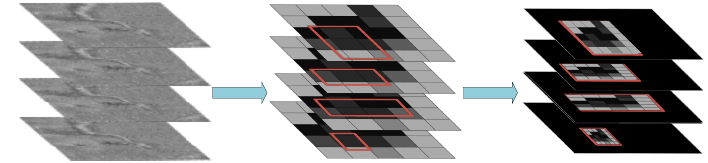
Figure 7. An illustration of ROI-focused feature